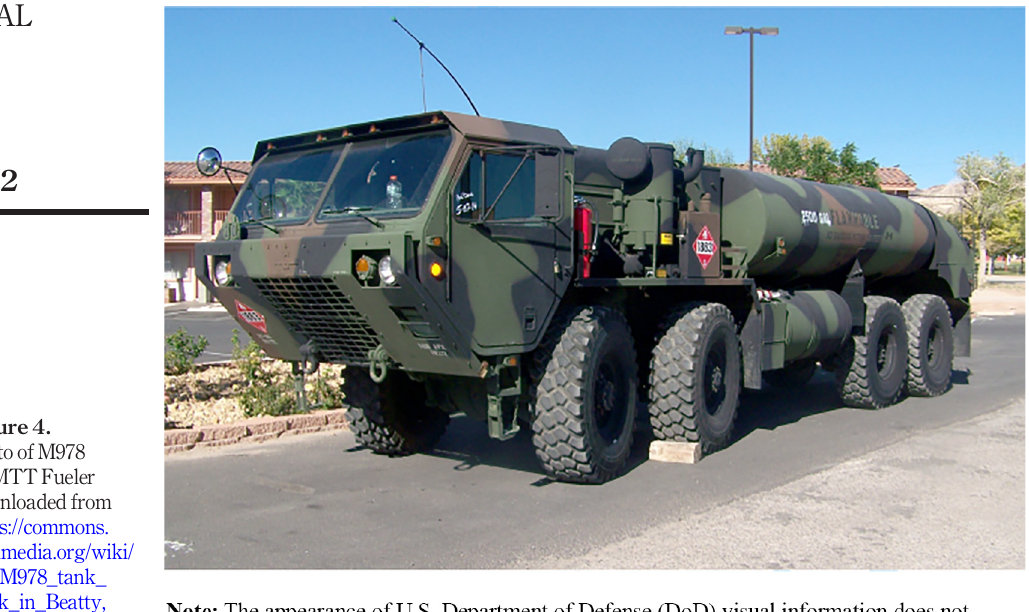
Figure 4. Photo of